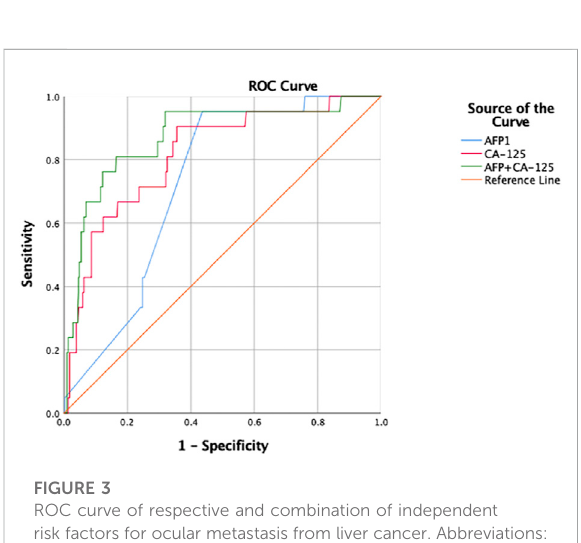
FIGURE 3 ROC curve of respective and combination of independent risk factors for ocular metastasis from liver cancer. Abbreviations: AUC, area under the curve; ROC, receiver operating curve.